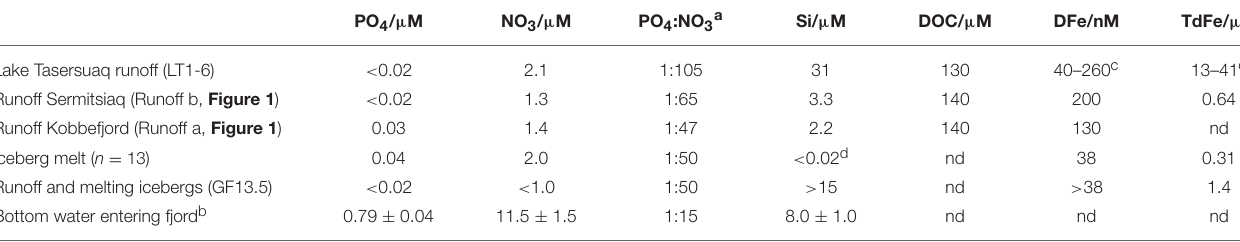
TABLE 2 | Nutrient content of fresh and low salinity water in the region of